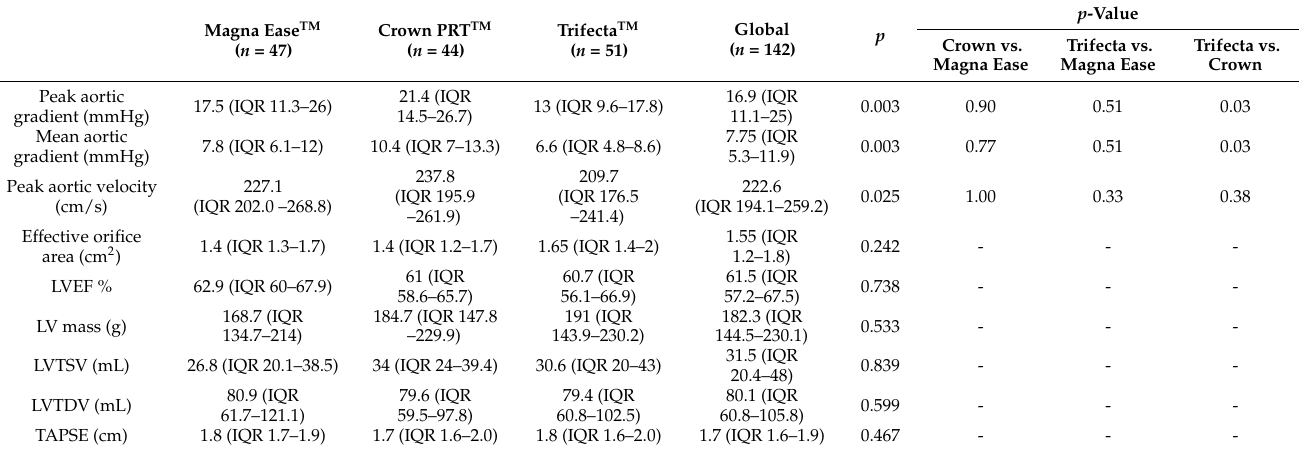
Table 2. Echocardiographic findings 12 months after